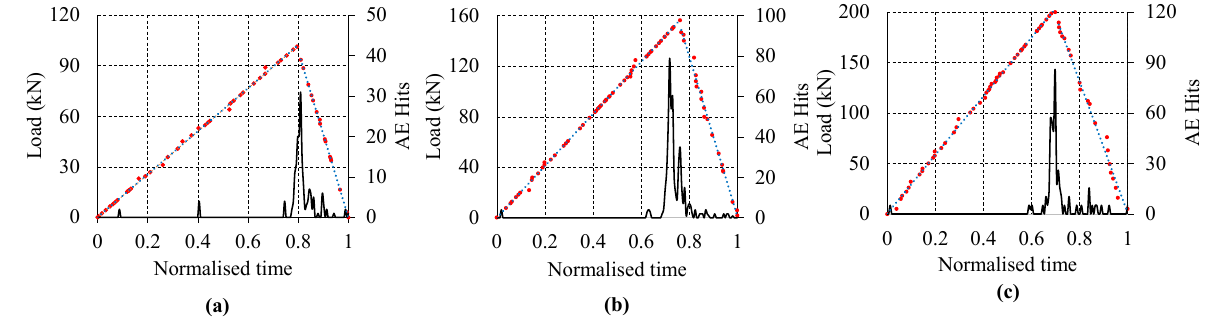
Figure 8. Recorded AE hits and load with respect to normalised time. ( a ) 100 kN, ( b ) 150 kN ( c ) 200 kN.